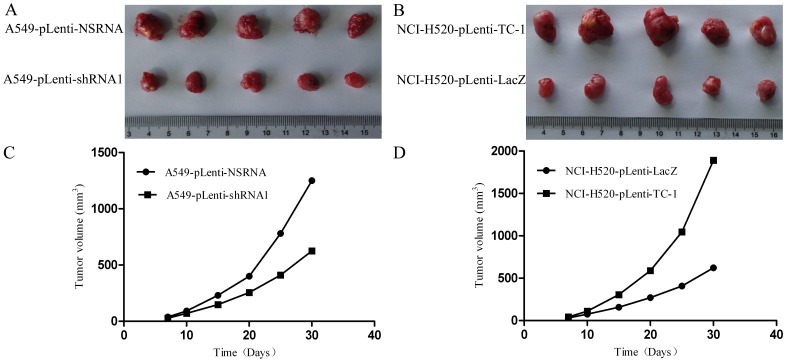
TC-1 has a significant impact on NSCLC cell proliferation in vivo.Subcutaneous tumor model (n = 5). Cells were subcutaneously injected into the flank of athymic nude mice, and the tumor volume was recorded every five days (C, D). The mice were sacrificed 30 days after injection, the tumors were removed, and photographs were taken (A, B).